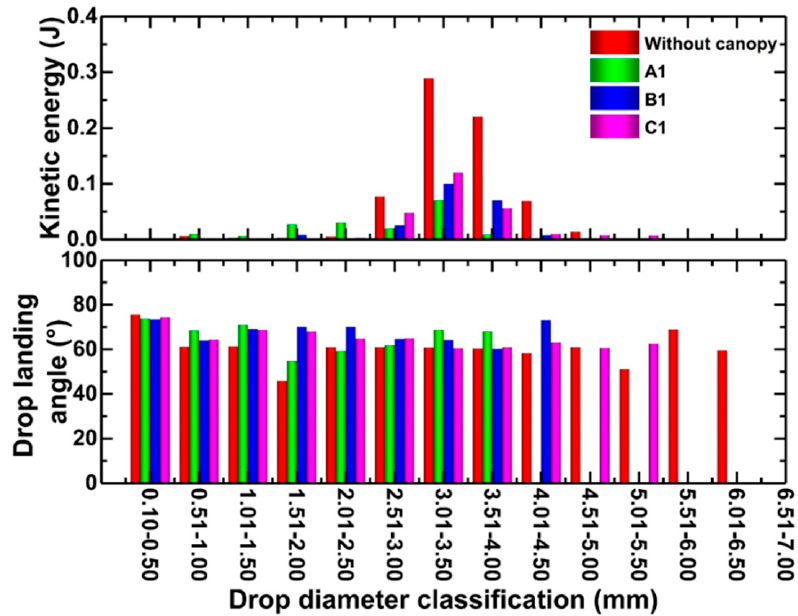
Figure 17. The kinetic energy and landing angle of droplets in different diameter ranges. If the sprinkler irrigation droplets are disturbed by maize leaves, the individual droplet’s velocity and kinetic energy will decrease gradually. Table 3 presents the mean values of individual droplet’s velocity and kinetic energy for the particle size range of 3.01–3.50 mm. As the data in Table 3 shown, the velocities and kinetic energy of individual droplets were less than uncrowned. The spatial distribution of individual droplets’ velocity and kinetic energy was similar to the droplet landing angle, as shown explicitly with by the maize leaves, and the measurement point was closer to the stalk, the disturbance would become more significant. Combined with the data in Figures 15 and 17, these results suggested that the effect of the maize leaves on the droplets in 3.01–3.50 mm was not sufficient to alter their landing angle or flight path